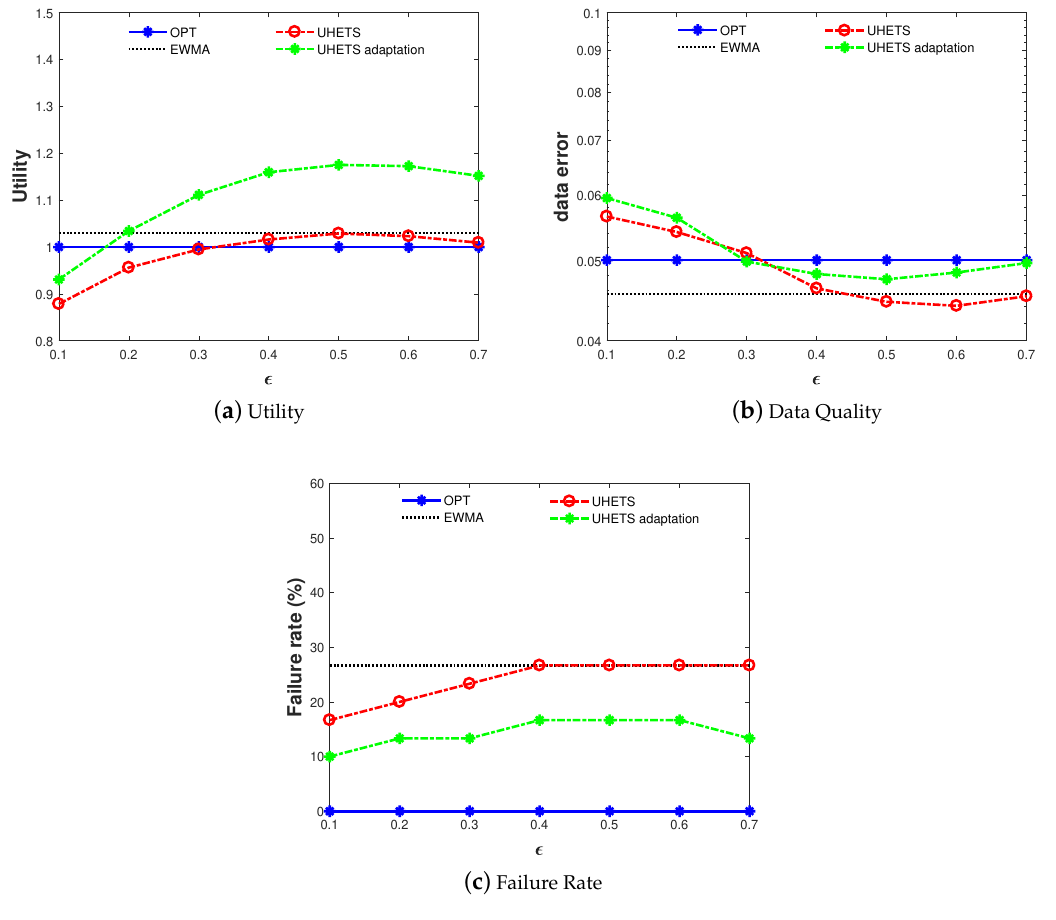
Figure 10. Performance of